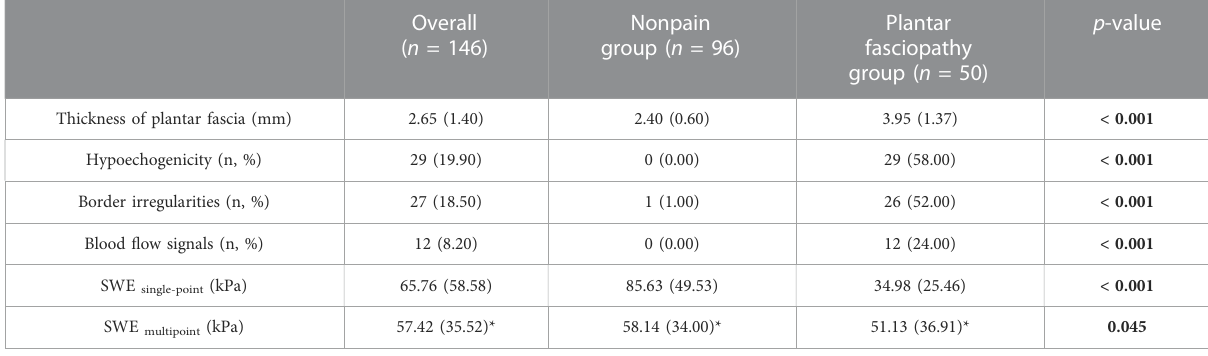
TABLE 3 Ultrasound features of the subjects in different